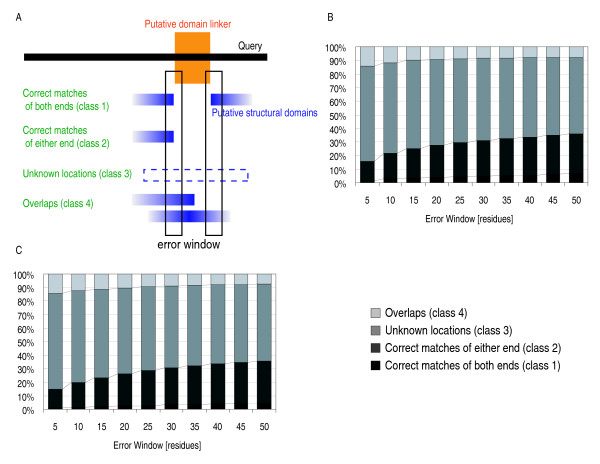
Classification of the predicted linkers and the low complexity regions. (A) Schematic representation of the positions of the predicted domain boundaries relative to the putative structural domains. The our classes are: correct matches at both ends (class 1), correct matches at either end (class 2), overlaps (class 4), and unmatched locations(class 3). Percentages of putative domain linkers (B) and low-complexity regions (C) in the four classes. An error window parameter, on the horizontal axis, is used to accommodate the terminal ambiguity of the assigned sequence regions. When the distance between the ends of a putative domain linker (B) or a low-complexity region (C), and the end of a putative structural domain was smaller than the error window, we considered the position of the predicted domain boundary to be correct. The error window parameter was varied from 5 to 50 residues.